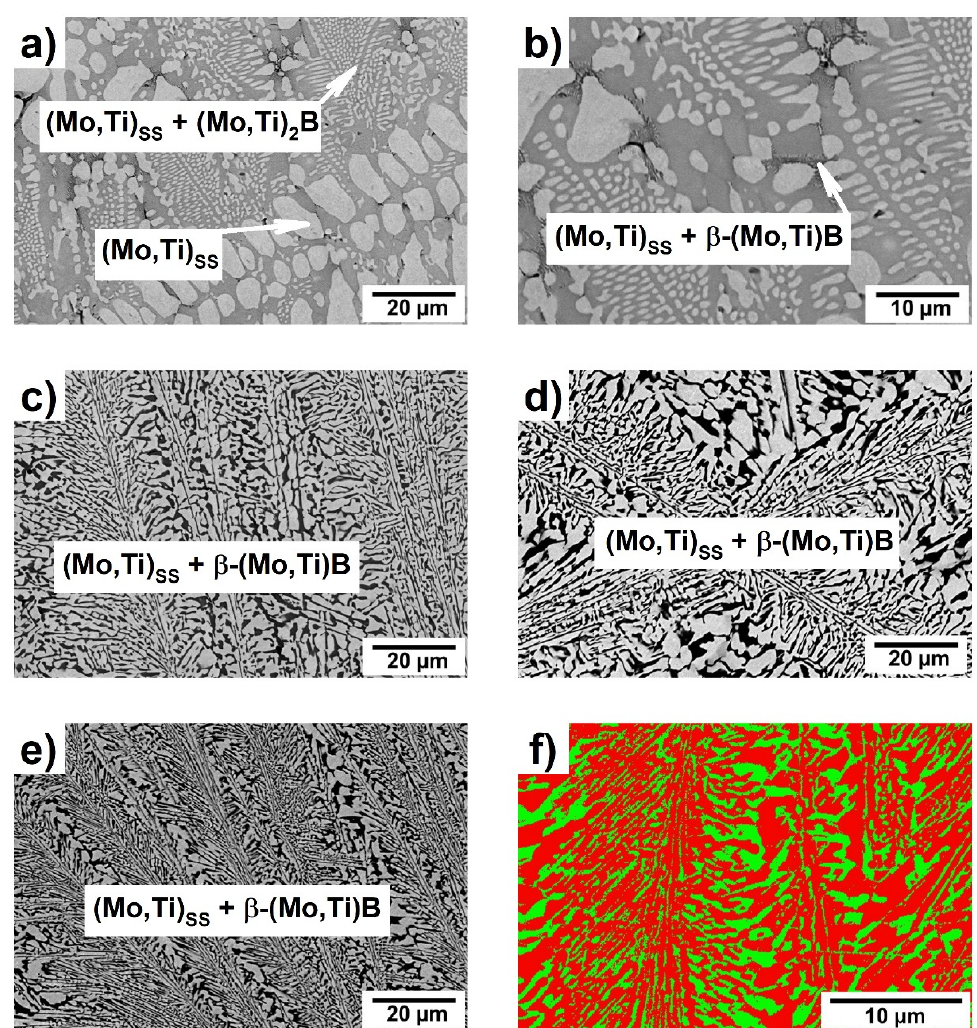
Figure 2. SEM-BSE micrograph of the as-cast Mo-Ti-B alloys: ( a , b ) Mo-8.3Ti-16.6B; ( c ) Mo-16.3Ti- 20.7B; ( d ) Mo-17.2Ti-21.8B; ( e ) Mo-17.4Ti-22.1 and ( f ) EBSD phase map of the as-cast Mo-17.4Ti-22.1B alloy: (Mo,Ti) SS —red; β -(Mo,Ti)B—green (15 kV, step size = 0.088 µm).